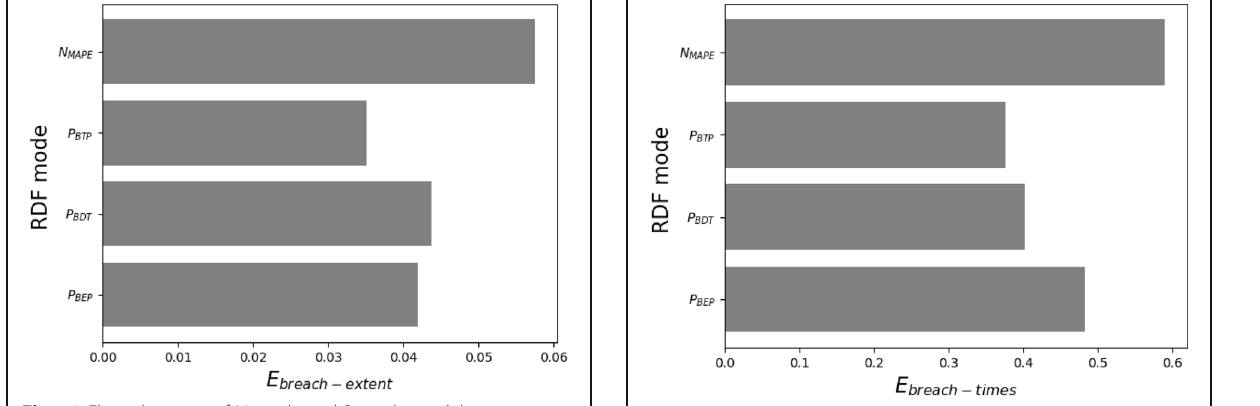
Fig. 14 Ebreach-times of N-mode and P-mode